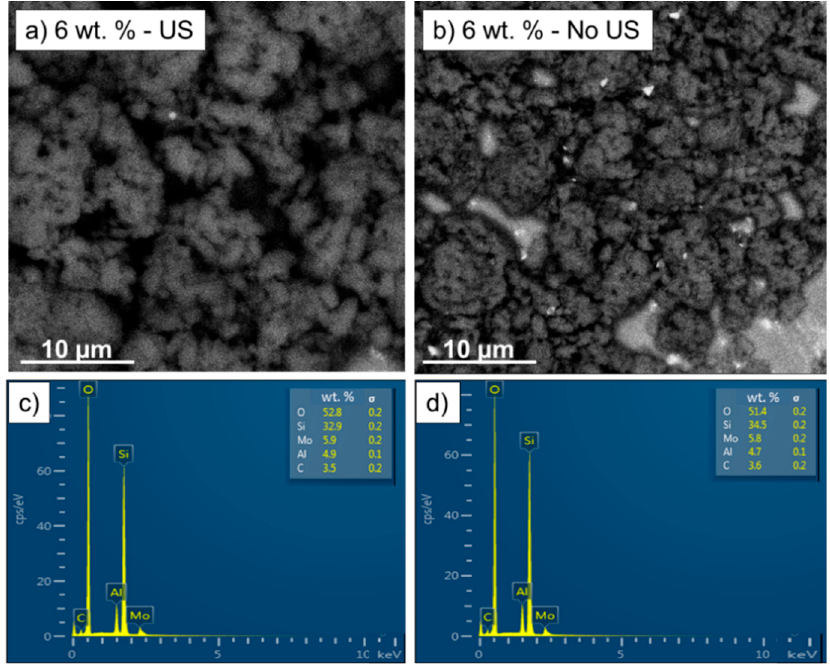
Figure 4. SEM images of Mo/ZSM-5 catalysts with 6 wt. % loading prepared ( a ) with ultrasound (US) and ( b ) without ultrasound (No US) taken with the backscattered electron detector and ( c,d ) their corresponding EDX analysis .